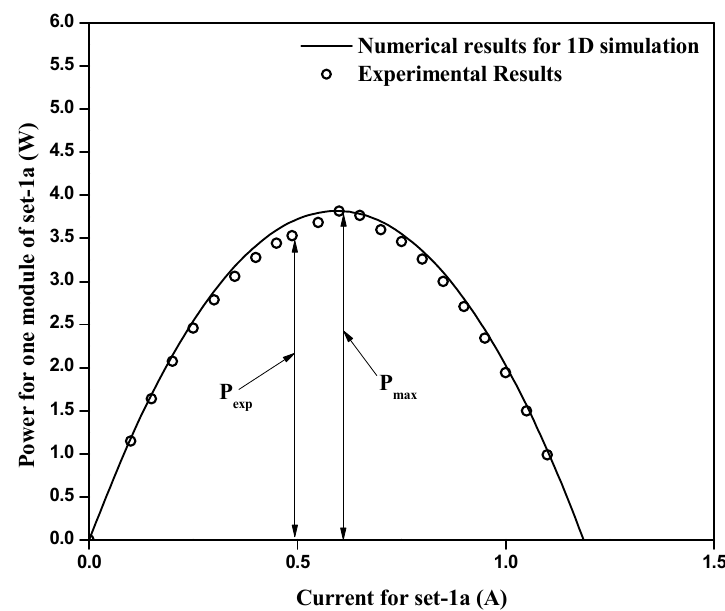
Energies 2021 , 14 , x FOR PEER REVIEW Figure 8. Thermoelectric generator potential as a function of total current. Figure 8. Thermoelectric generator potential as a function of total current.